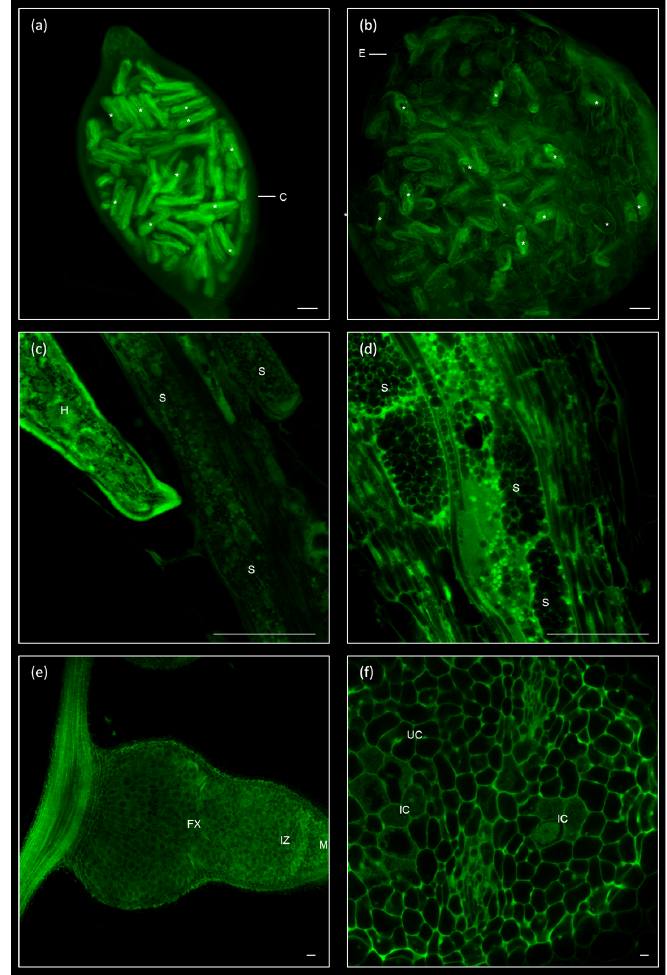
Figure 5. Other biotic interaction can be visualized after fixation and clearing. ( a ) Female of a cyst nematode, Heterodera schachtii, filled with eggs one month after infection. ( b ) Egg mass from Meloidogyne javanica filled with eggs, two months after infection. ( c , d ) Syncytia induced by Heterodera schachtii in Arabidopsis thaliana at nine days after infection. Details of the nematode protruding the syncytial cells ( c ) or of the dense and multinucleated syncytium ( d ). ( e , f ) Nodule induced by Sinorhizobium meliloti 2011 in Medicago truncatula R108 roots. Longitudinal view with attachment to the root ( e ) or detailed view, or the fixing zone, showing dense infected cells and adjacent uninfected cells ( f ). Scale bars: 50 μ m. Asteriks (*): eggs; C: cyst; E: egg mass; H: Heterodera schachtii ; S: syncytium; M: meristem; IZ: infection zone; FX: fixing zone; IC: infected cell; UC: uninfected cell.